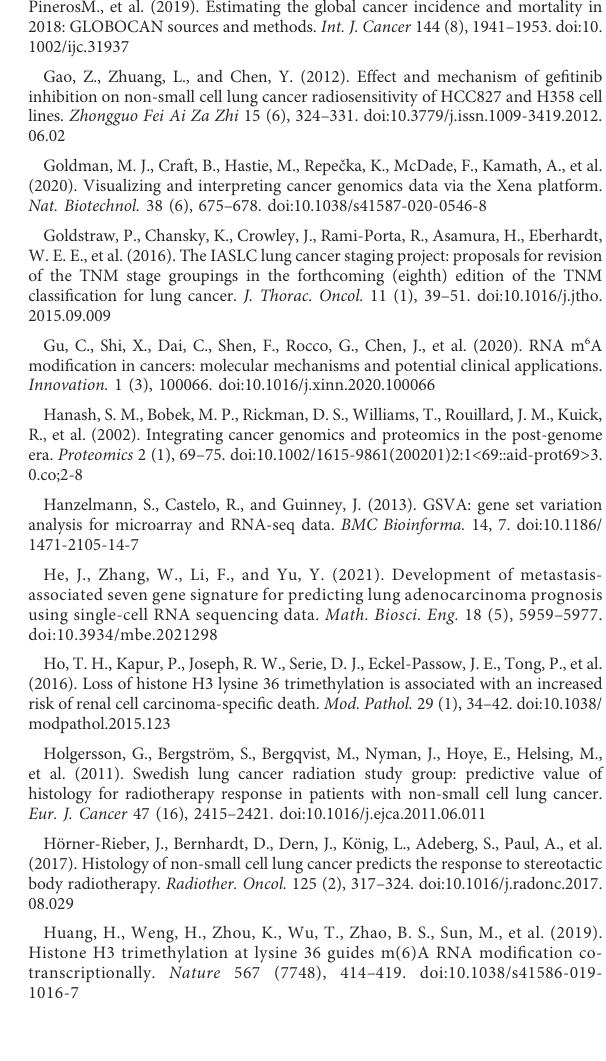
GSVAanalysisof7LUADsingle-cell-derivedmetastasis-associatedgenes (PRSS3, GPI, CCL20, KRT18, TCN1, SLCO1B3, and GNPNAT1) between SETD2-positive and negative tumor cells in GSE131907. SUPPLEMENTARY TABLE S1 The basic information of included datasets. SUPPLEMENTARY TABLE S2 SF2 values from previous laboratory studies. SUPPLEMENTARY TABLE S3 Multivariate Cox regression with RBM15 * SETD2 interaction. SUPPLEMENTARY TABLE S4 Multivariate Cox regression with YTHDF3 * SETD2